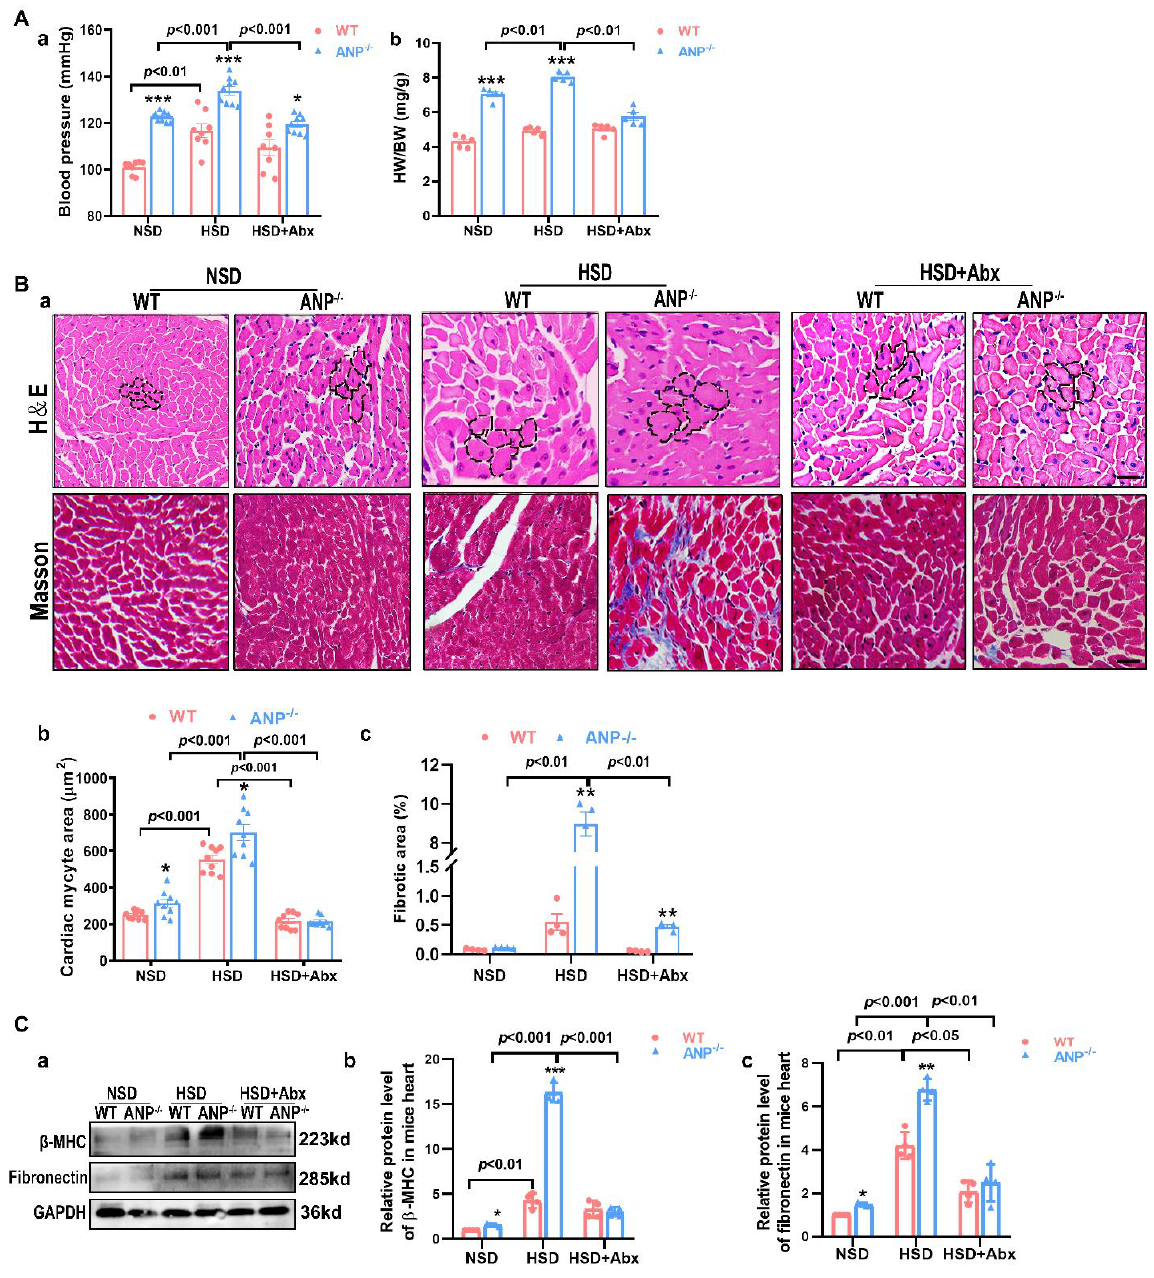
Figure 1. Effects of antibiotics on BP and cardiac pathology in the ANP − / − salt-sensitive model. ( A ) Systolic blood pressure ( n = 4–7) ( a ), and the heart weight/body weight (HW/BW) ratio ( n = 4–5) ( b ). ( B ) Representative histological images of H&E- and Masson trichrome-stained cardiac sections and the myocardial area ( a ) , quantification of the myocardial area evaluated from H&E-stained tissue sections ( n = 9) ( b ), and quantification of cardiac fibrosis from Masson trichrome-stained cardiac sections ( n = 4) ( c ). ( C ) Representative Western blots of β -MHC and fibronectin ( a ) expression in cardiac tissue, relative quantification of β -MHC ( b ) , and fibronectin ( c ) expression from Western blot images, ( n = 3 – 4). Scale bar = 50 μ m. The p values were evaluated by two-way ANOVA. Significant difference compared to wild type, * p < 0.05, ** p < 0.01, and *** p < 0.001.